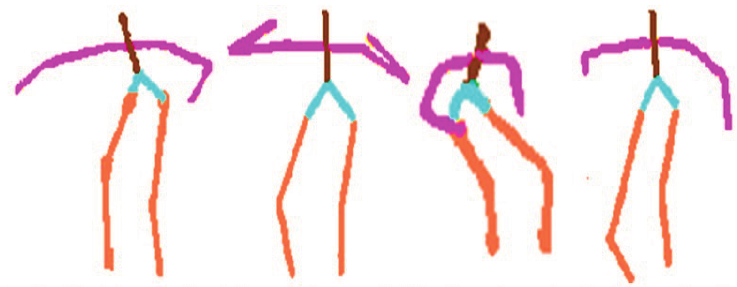
Figure 3. Body skeleton derived from different human activities.